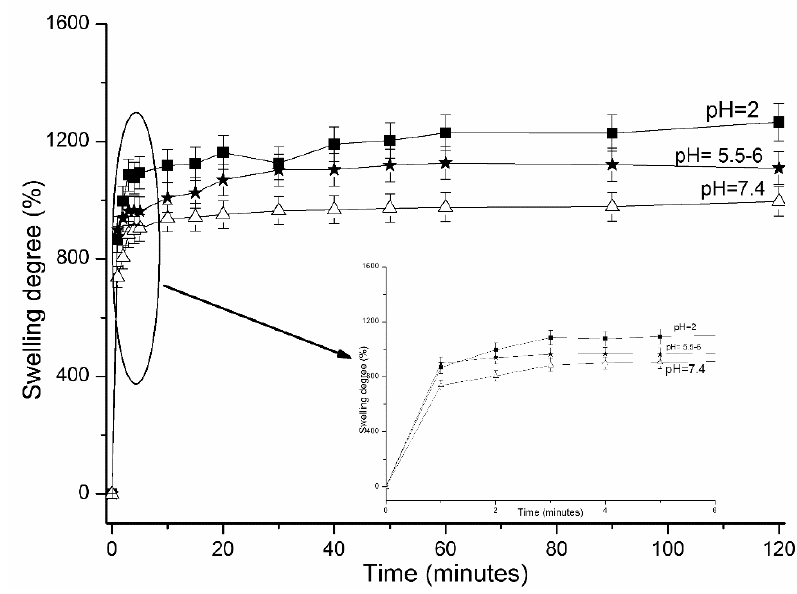
Figure 5. Swelling behavior of CS -g- PNIPAAm/PVA 75/25 hydrogel at different pH values.